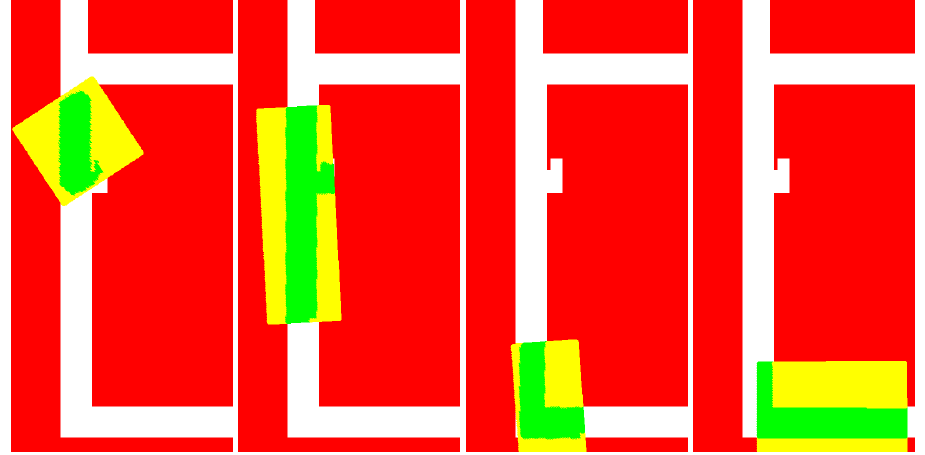
Figure 13. Example of the APM performance. A single grid is placed and rotated with respect to the map and the position estimation certainty. White color denotes accessible areas. Green points in the grid have positive belief values. Yellow points are placed on inaccessible